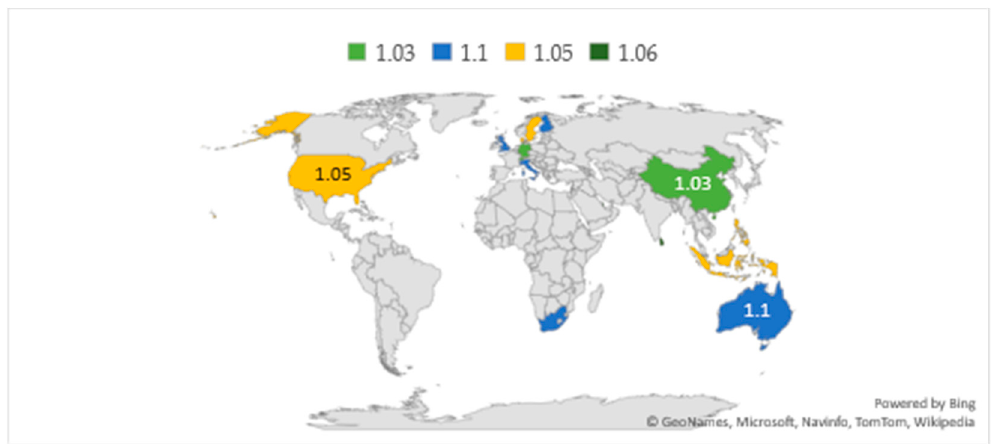
Figure 3. Most widely employed voltage rise limits in standards across countries. Table 2. Voltage rise standards due to PV integration of different countries as per different studies. Voltage Rise Countries